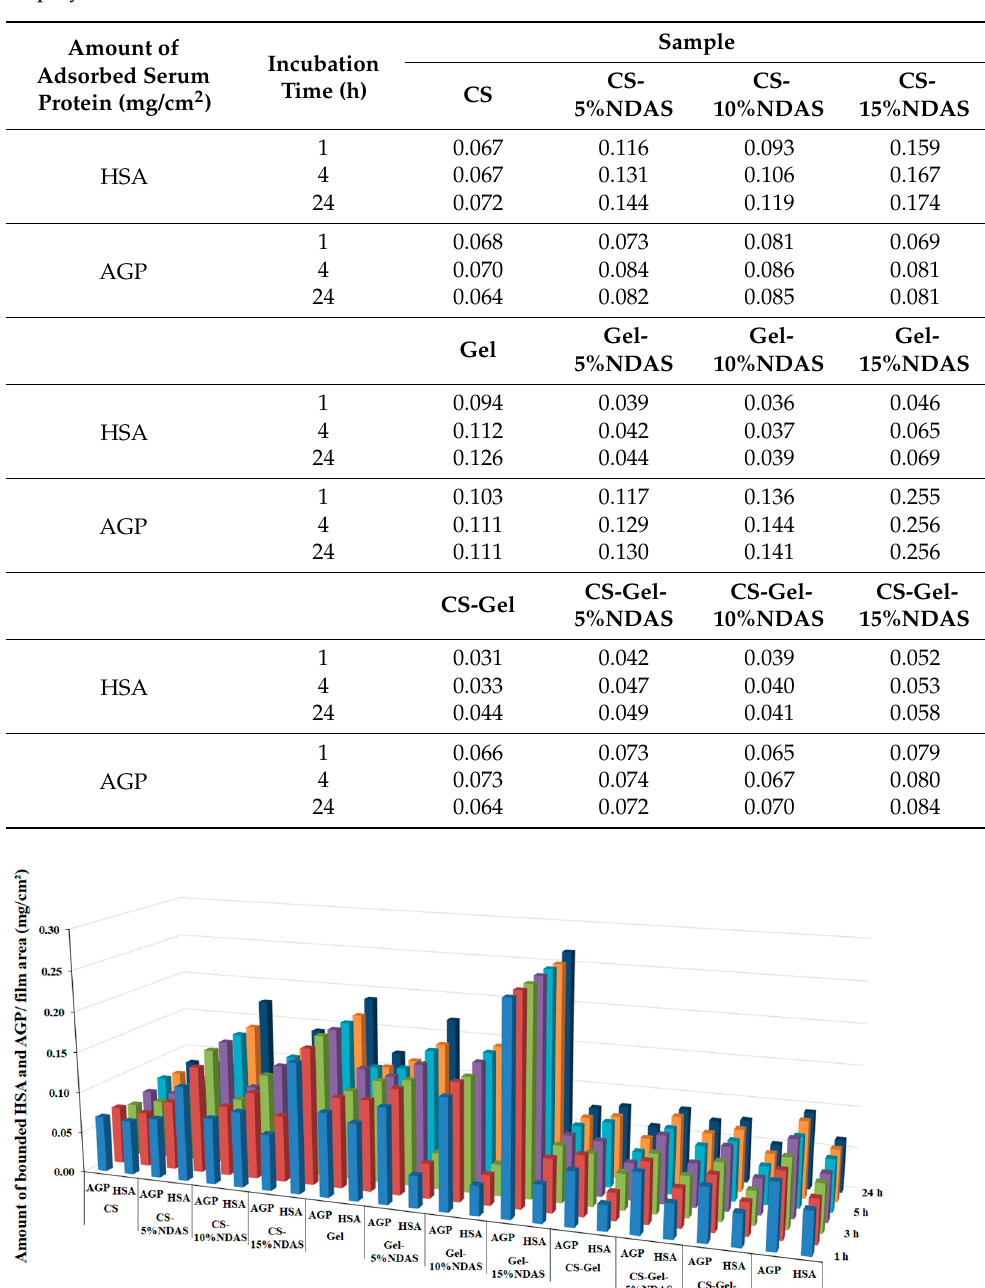
Table 3. Amount of protein bound on the surface of biopolymers in mg of protein per 1 cm 2 of biopolymer film, after 1, 4, and 24 h of incubation.